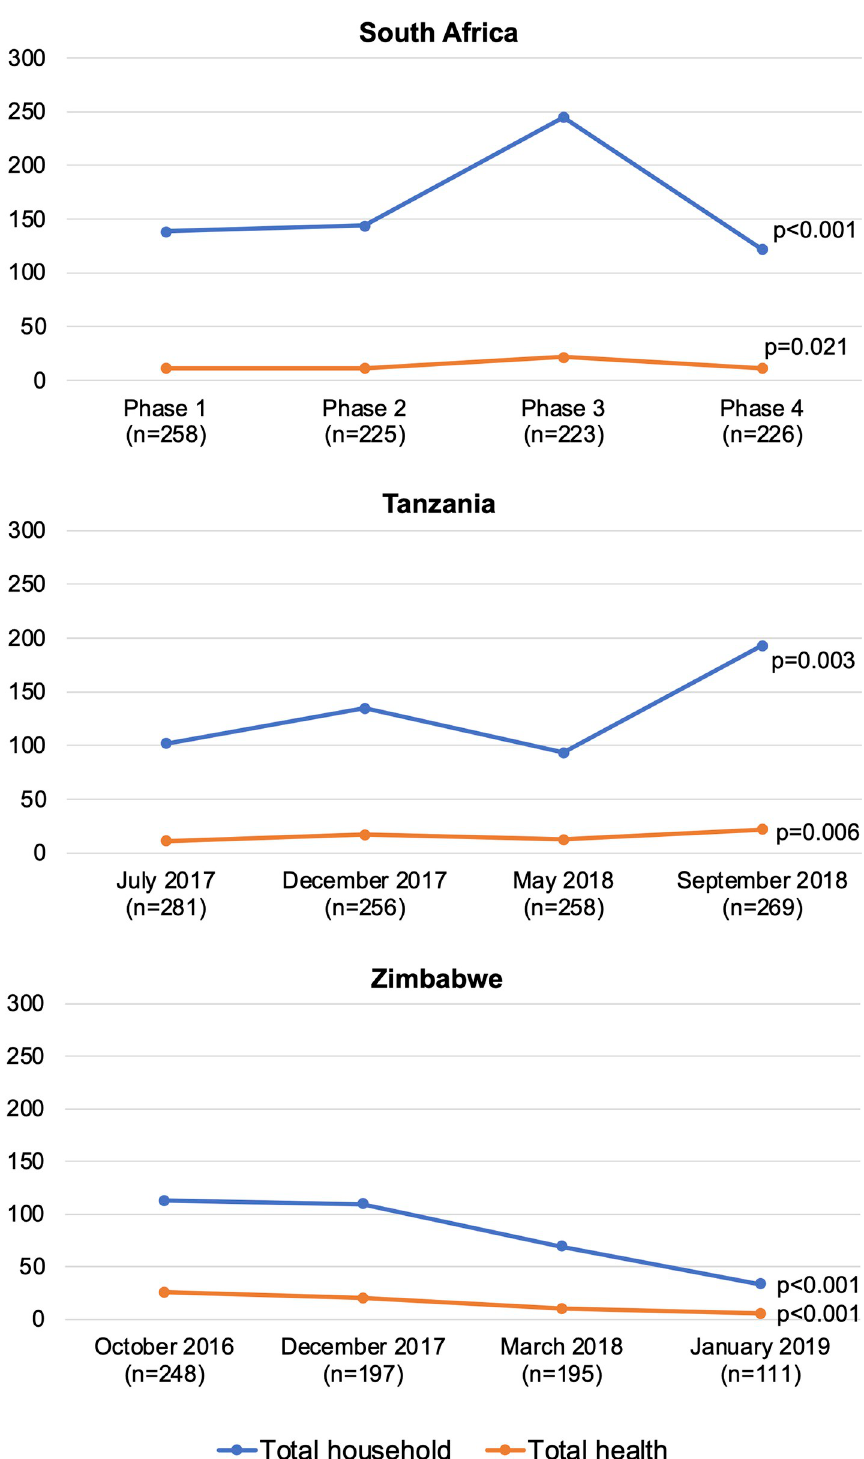
Fig 3. Mean monthly total household and health per capita expenditure by diary data collection phase, 2014 USD. p-values from the ANOVA test for the equality of means across the four phases.